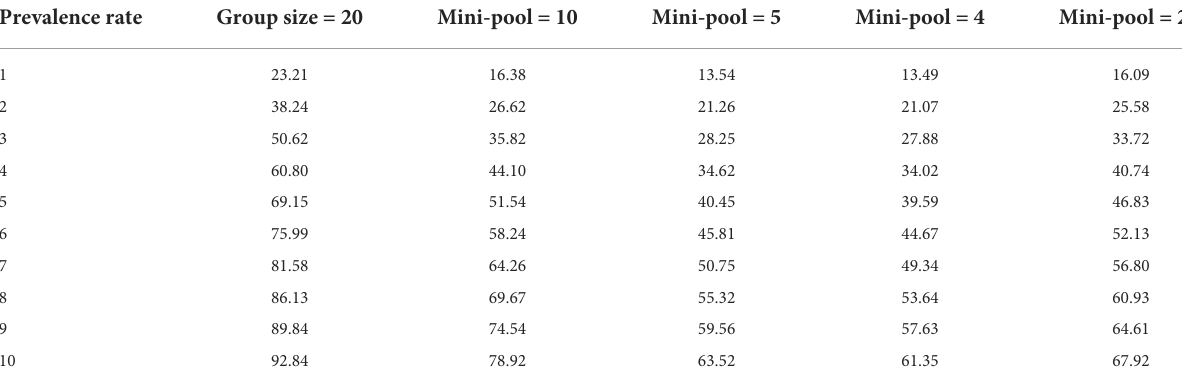
TABLE 2 Expected number of tests using different mini-pool sizes. Prevalence